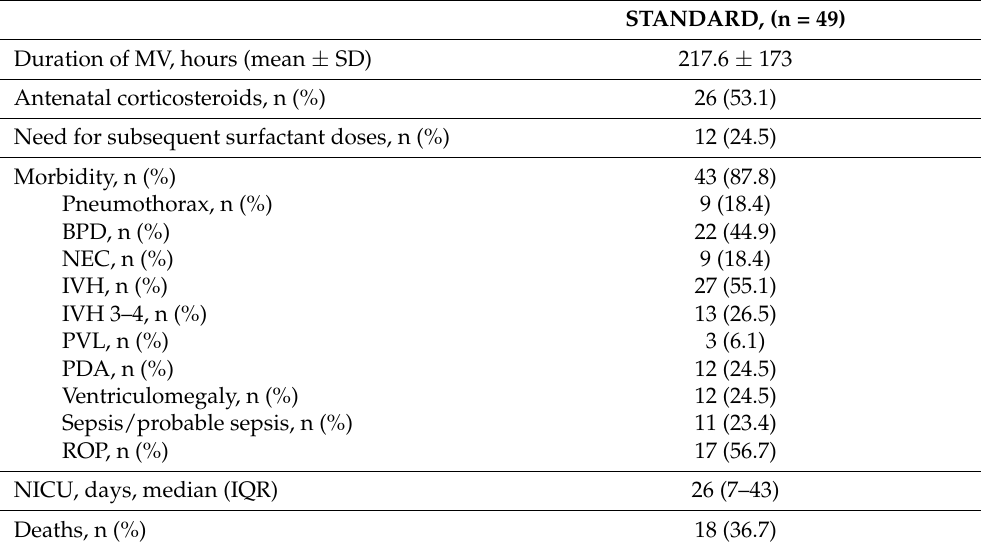
Table 2. Clinical characteristics of premature infants who were administered surfactant by the standard